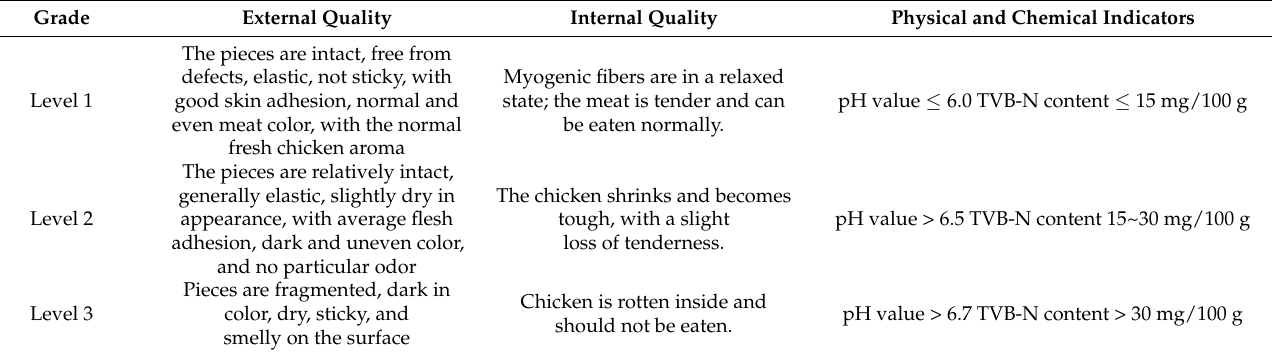
Table 1. Sensory grading scale for chicken.